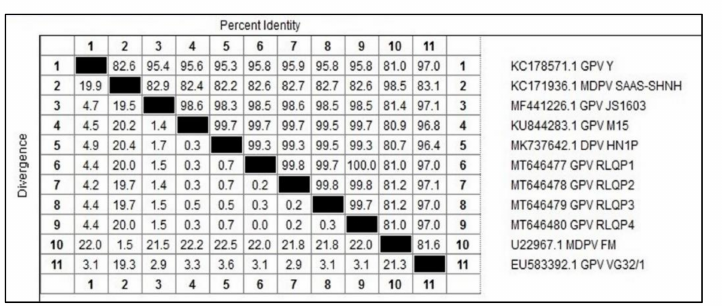
Figure 4. Nucleotide identities of the VP1 gene for Egyptian isolates with selected references and vaccine